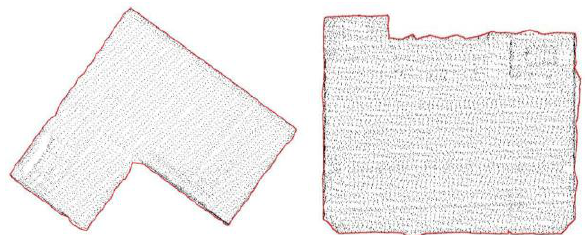
Figure 6. Alpha shapes of two building outlines with overlaid building points.